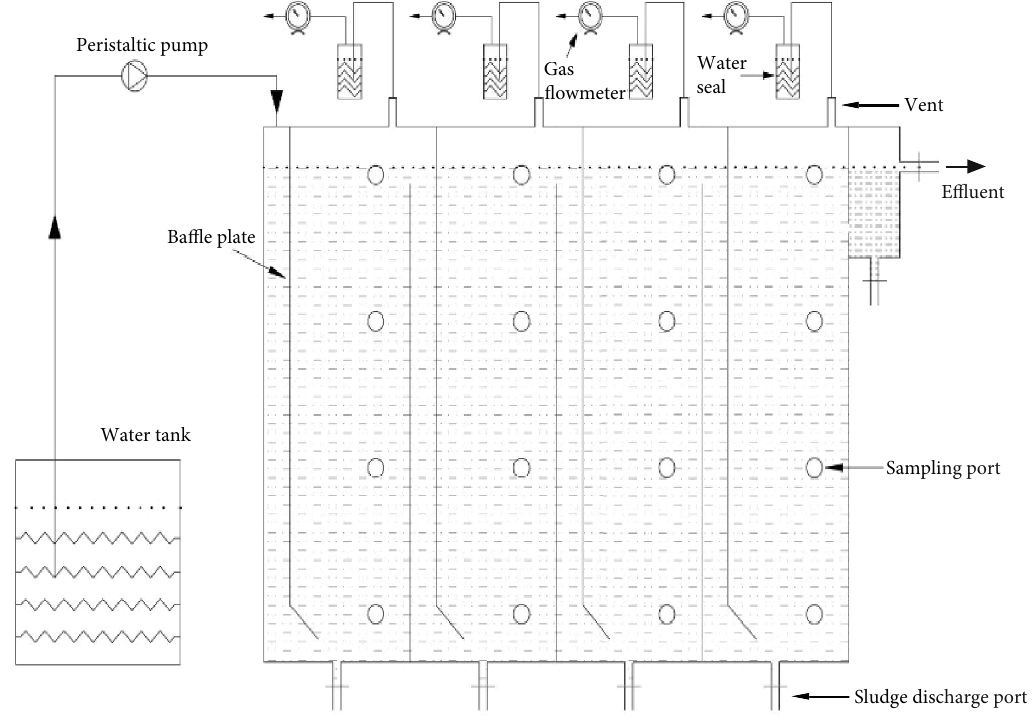
Figure 1: Schematic of ABR. Table 1: Start-up parameters of ABR.